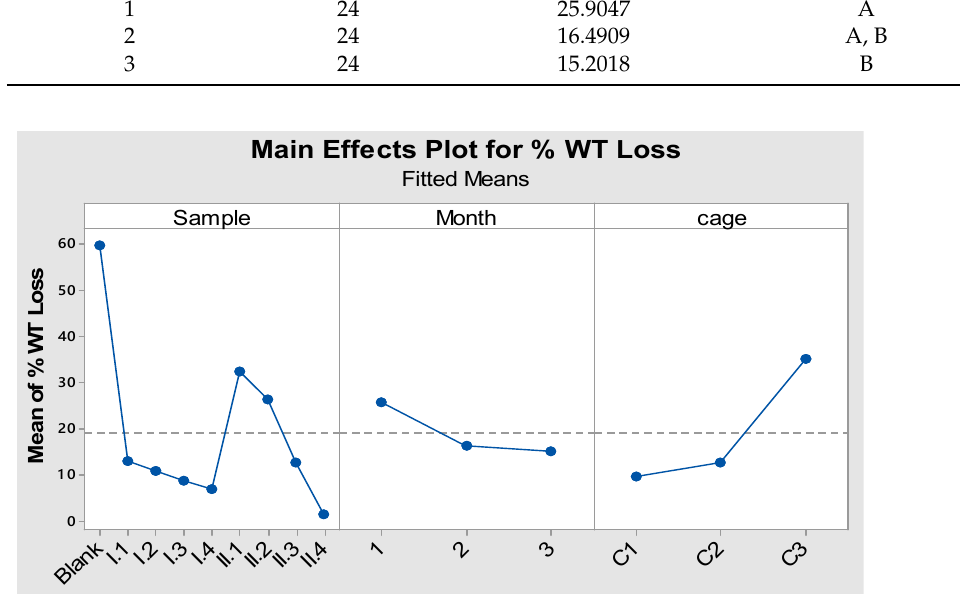
Figure 8. Effect of substances concentration, number of rats and time on percentage of weight loss. Table 5. Grouping information of samples using the Tukey method and 95% confidence.